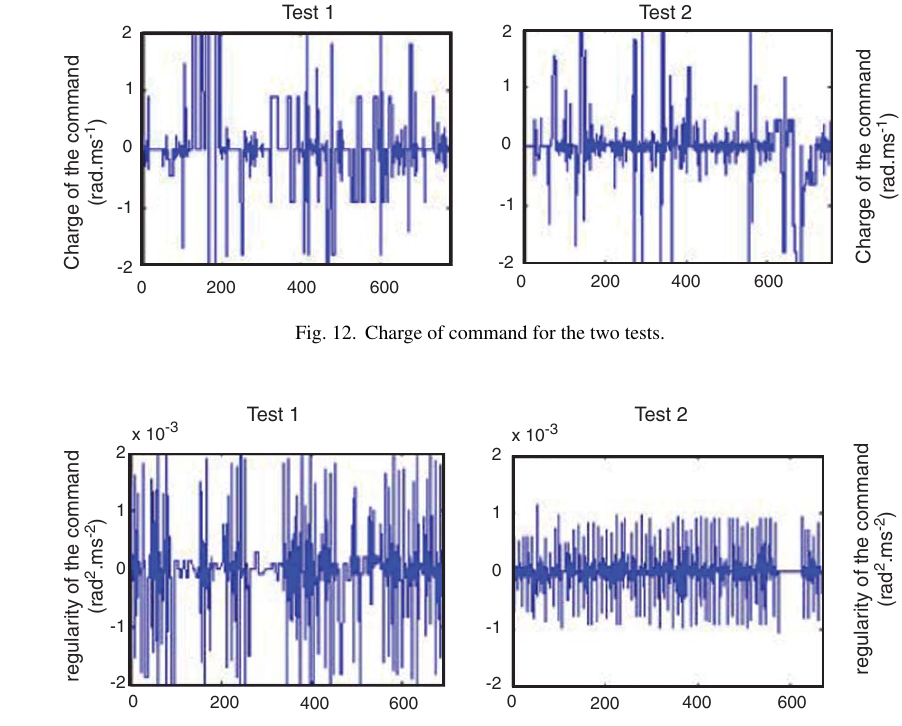
Fig. 13. Regularity of command for the two tests.